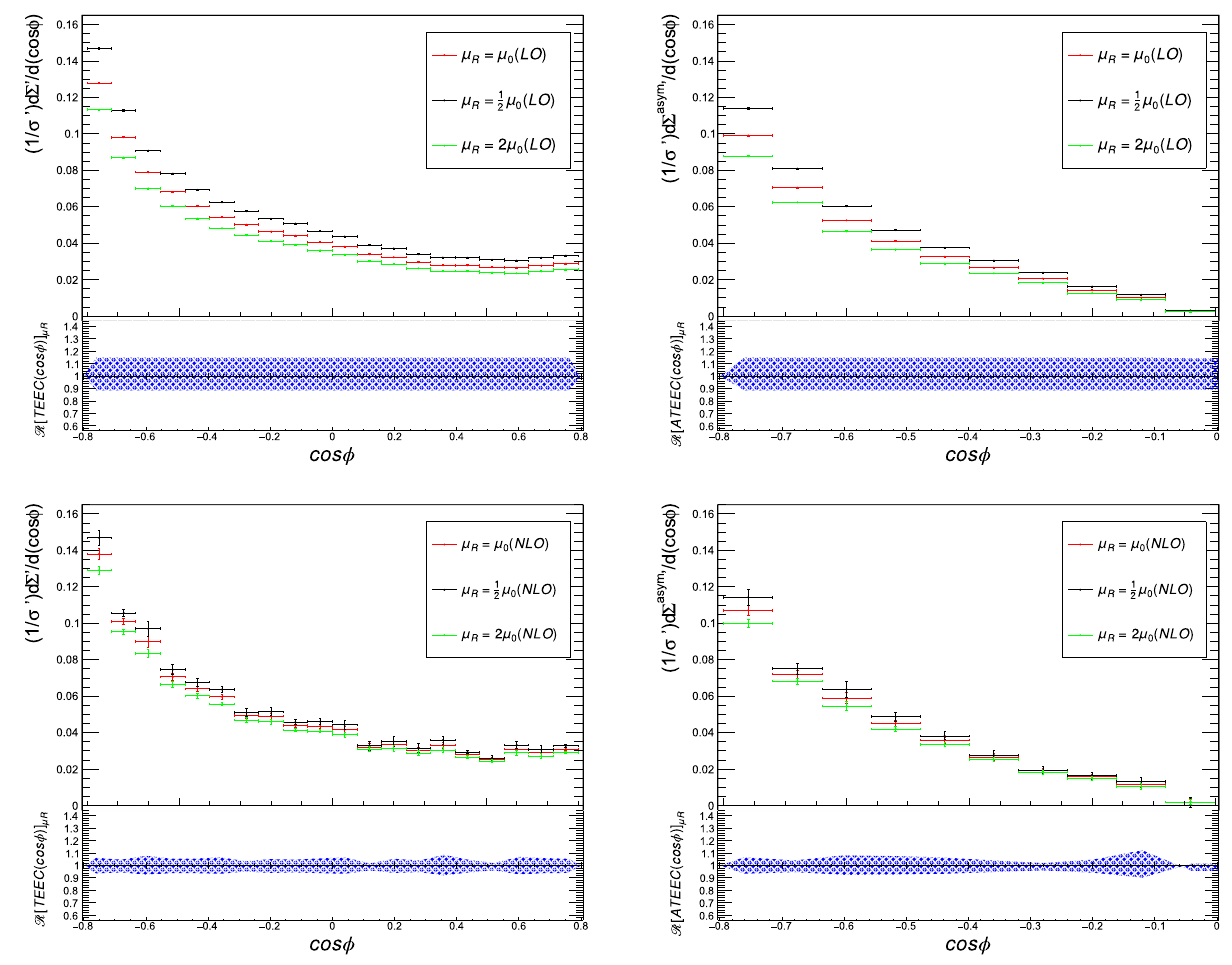
Fig. 7 Renormalization scale dependence of the differential distribution 1 /σ (cid:7) d (cid:9) (cid:7) / d ( cos φ) and its asymmetry 1 /σ (cid:7) d (cid:9) (cid:7) asym / d ( cos φ) in the leading order (upper frames) and the next to leading order (lower frames) as in Fig. 6, but for the high- Q 2 range: 150GeV 2 < Q 2 < 1000GeV 2